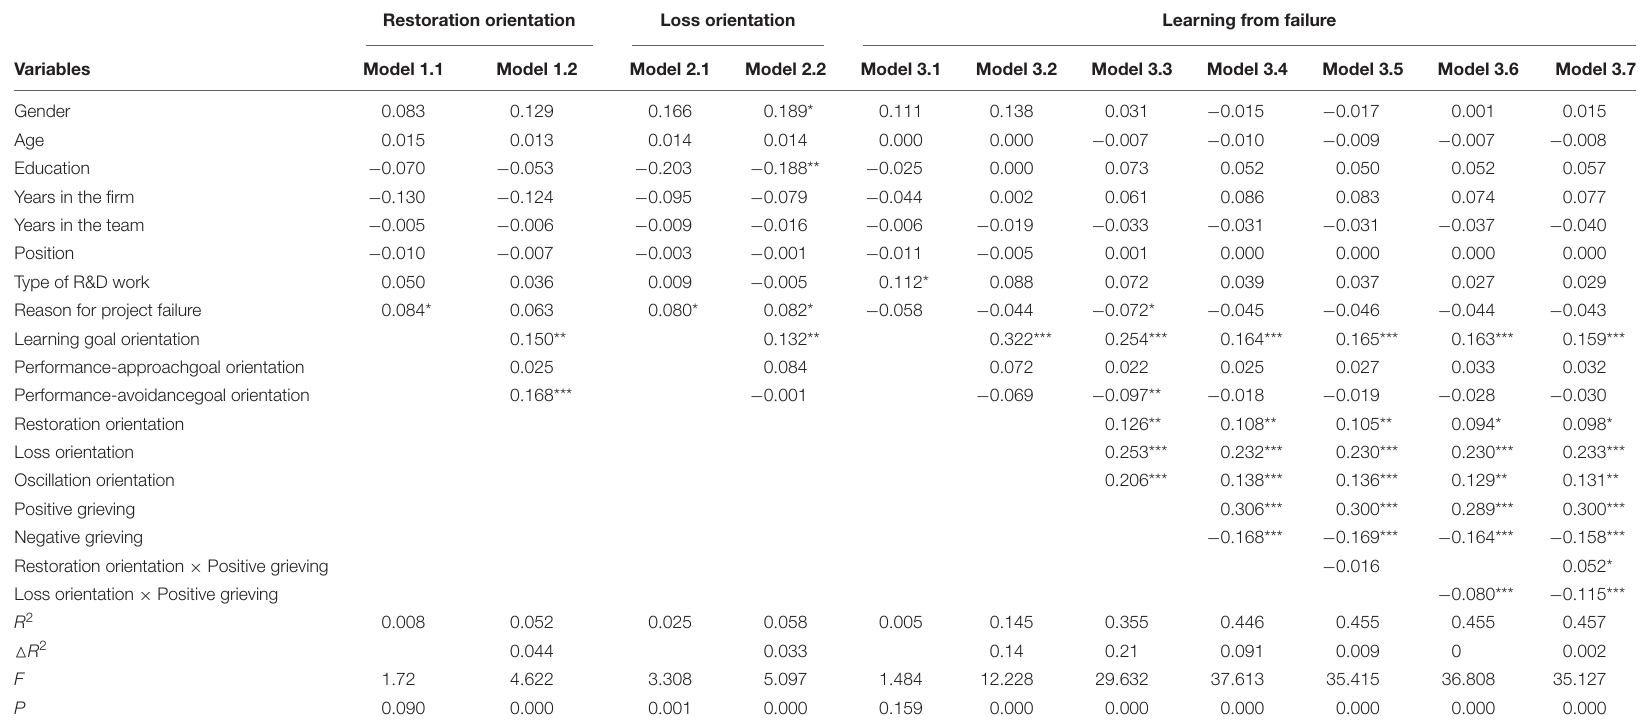
TABLE 3 | Hierarchical regression analysis for